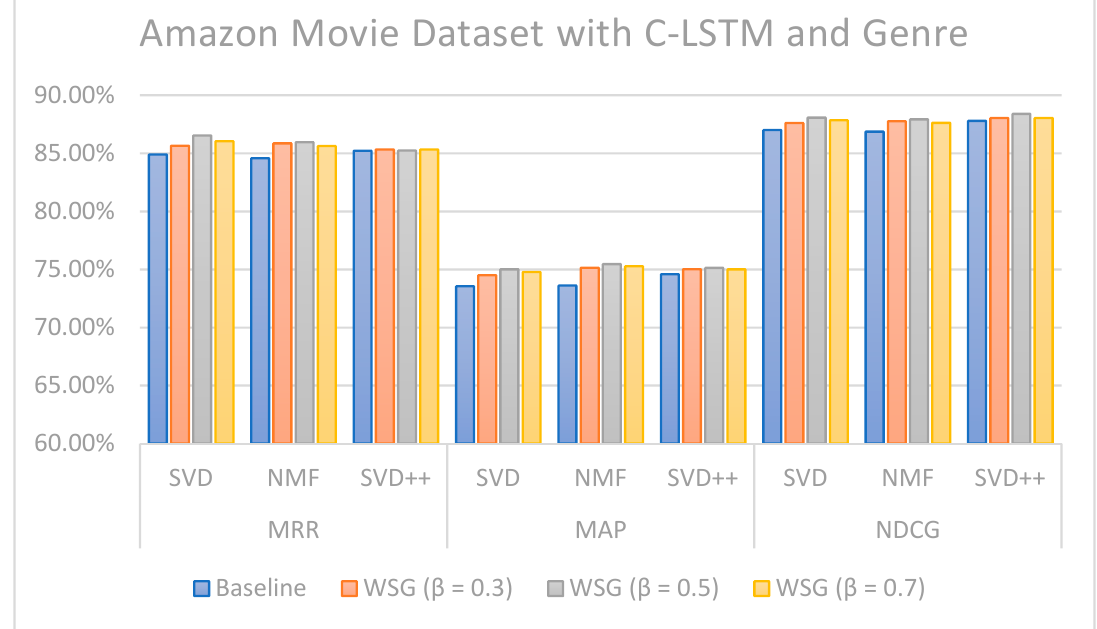
Figure 7. MRR, MAP, and NDCG values with C-LSTM sentiment and genres-based model on Amazon Movie dataset with different β values.